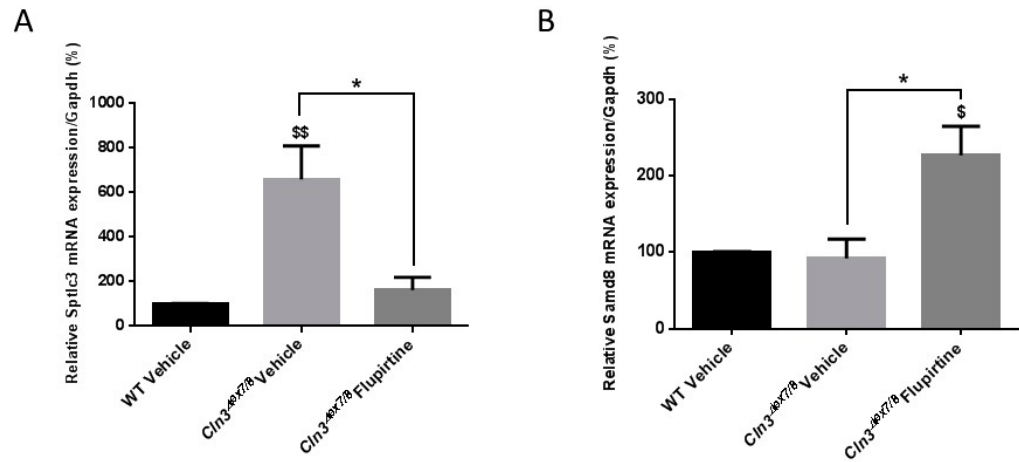
Figure 5. Mouse brain gene expression of ceramide synthesis / degradation enzymes. ( A ) Sptlc3 gene expression levels in the brain of vehicle-treated WT, vehicle-treated Cln3 ∆ ex7 / 8 , and flupirtine-treated Cln3 ∆ ex7 / 8 male mice ( n = 4 per group). Data are expressed as mean ± SEM. $ p : compared to WT vehicle-treated mice, and, * p : compared to vehicle-treated Cln3 ∆ ex7 / 8 mice. * p < 0.05, and $$ p < 0.01; ( B ) Samd8 gene expression levels in the brain of vehicle-treated WT, vehicle-treated Cln3 ∆ ex7 / 8 , and flupirtine-treated Cln3 ∆ ex7 / 8 female mice ( n = 4 per group). Data are expressed as mean ± SEM. $ p : compared to vehicle-treated WT mice, and, * p : compared to vehicle-treated Cln3 ∆ ex7 / 8 mice. * p < 0.05 and $ p < 0.05.